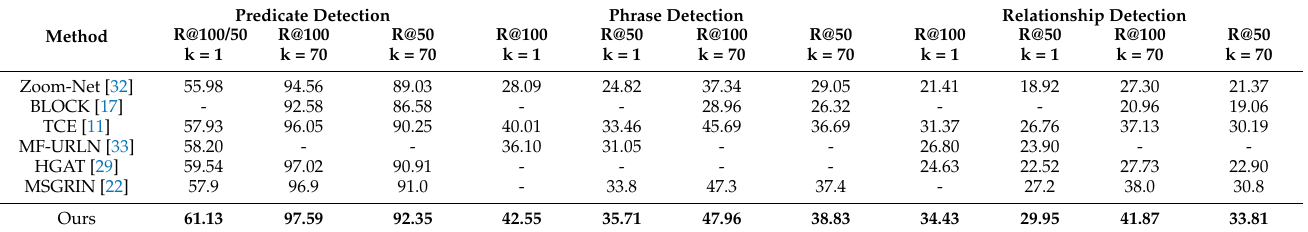
Table 1. Comparison with previous methods on VRD, where bold font indicates the best results.